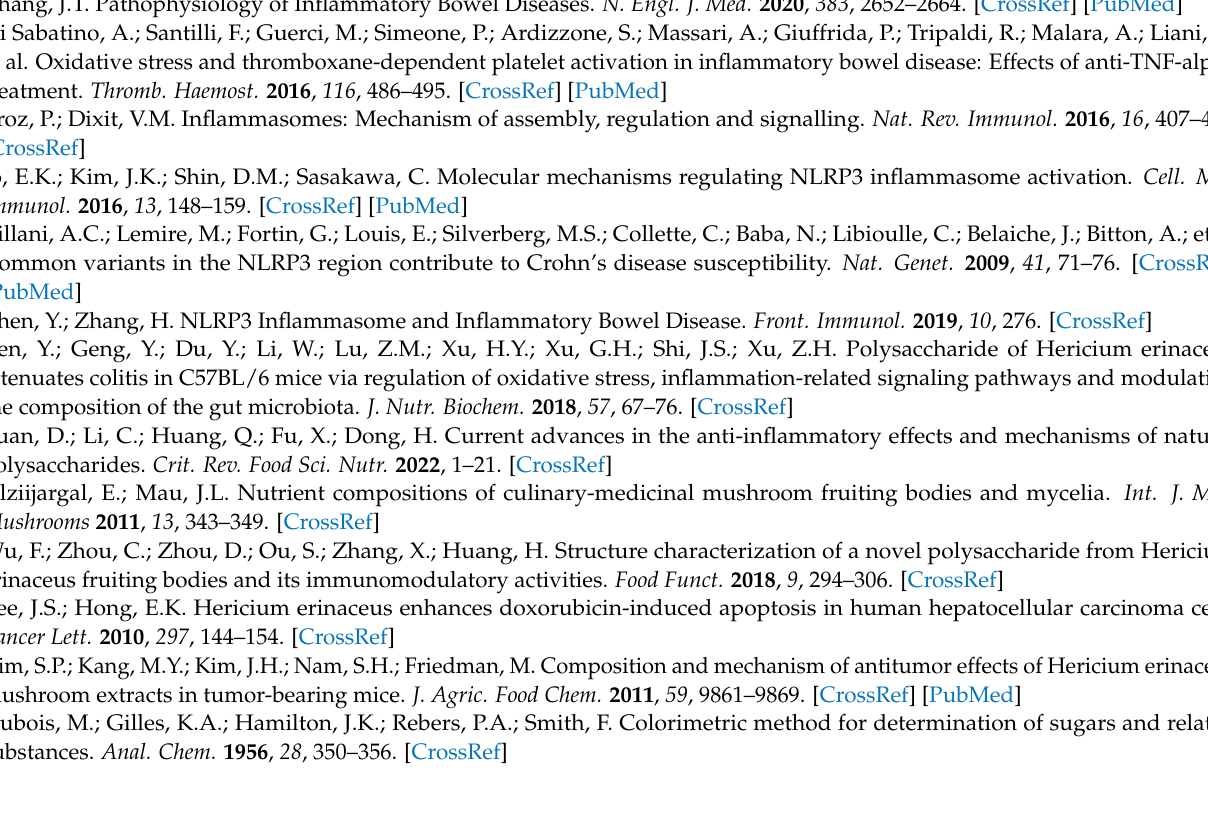
Figure S6: Prediction of metabolic function and the concentrations of SCFAs in the DSS-induced mice after HEP10 (200 mg/kg)